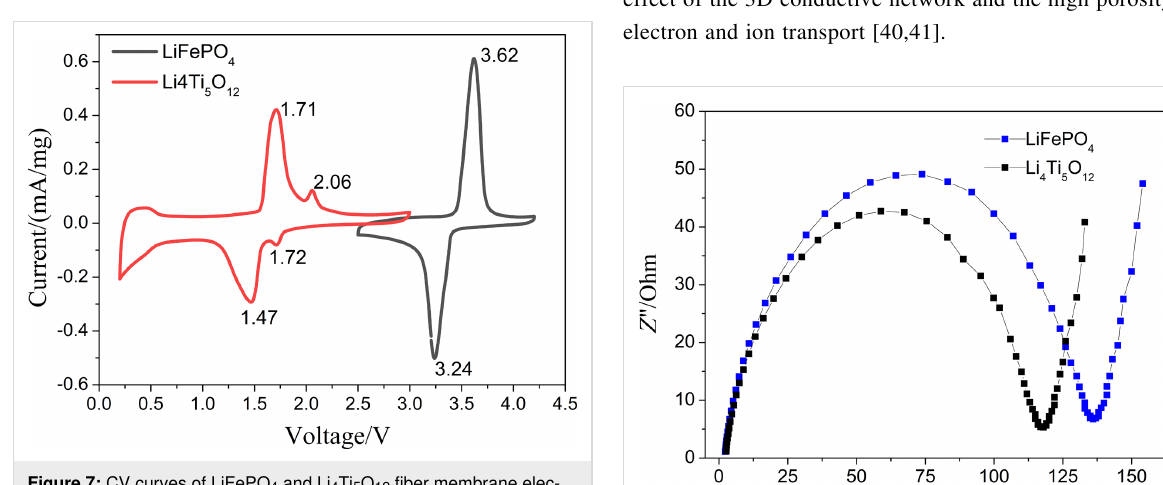
Figure 7: CV curves of LiFePO 4 and Li 4 Ti 5 O 12 fiber membrane elec- trodes.